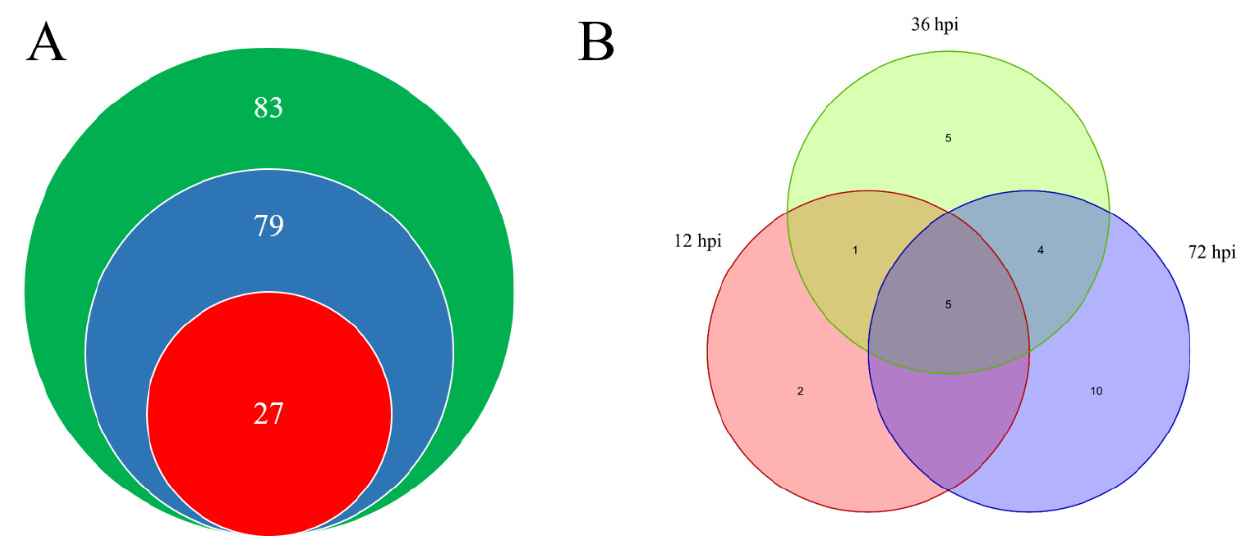
Figure 1. The differentially expressed WRKY genes in LA1777 under On -lz infection. In figure ( A ), red color represents the differentially expressed WRKY genes, and blue color represents the WRKY transcripts in LA1777 under On -lz infection and green color represents the WRKY genes in S. lycopersicum genome. ( B ) The distribution of differentially expressed WRKY genes at different time points.